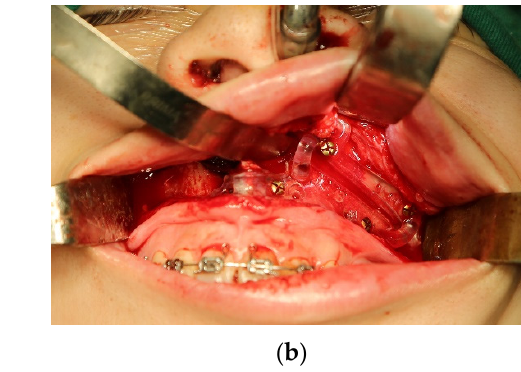
Figure 1. ( a ) The 3D-printed surgical guides recorded the orientation and thickness of the surgical cuts. The screw holes over the surgical guides also served to guide the placement of the prebent fixation plates after jawbone repositioning. ( b ) The guidance plates were accurately affixed onto the maxillary surface to provide cutting guidance.